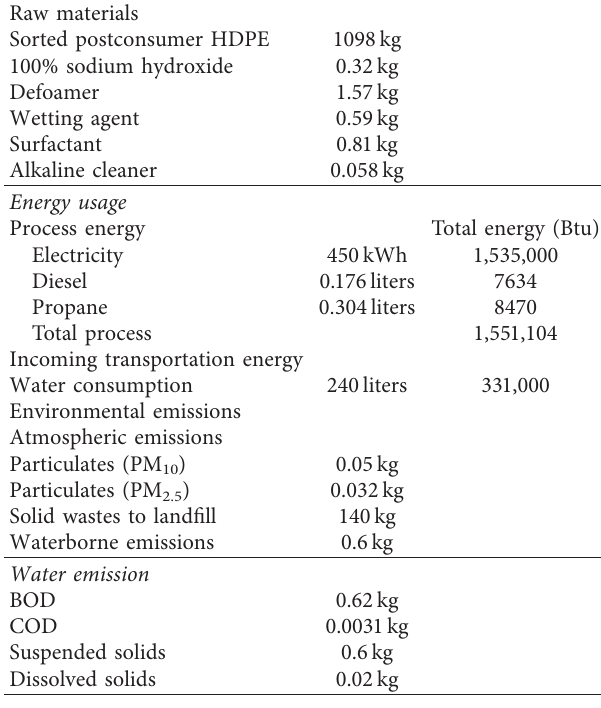
Table 7: Data for the processing of 1 ton of the postconsumer recycled HDPE pellet.